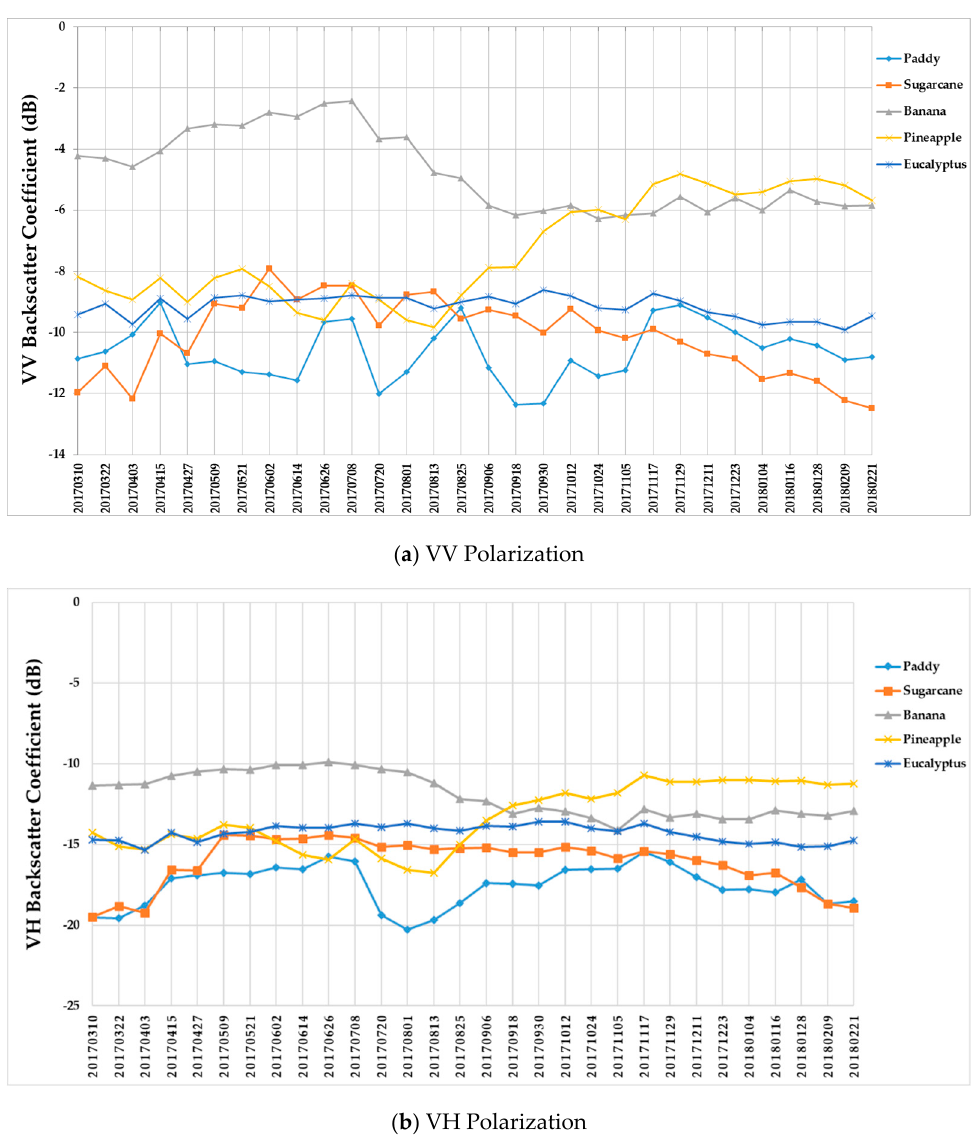
Figure 9. Temporal profiles of the five different crop types with respect to the ( a ) VV and ( b ) VH backscatter coefficient (dB).